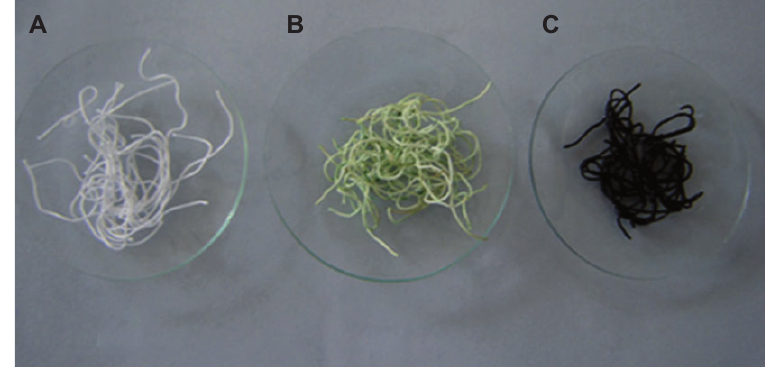
Figure 4 Picture showing plain cotton fibers (A), copper-bound chitosan-attached cellulose fibers (B), nanocopper loaded chitosan cotton fibers (C). Reprinted from J. Appl. Polym. Sci., 2009, vol. 11, Grace M, Bajpai SK, Chand N, Copper (II) ions and copper nano- particles-loaded chemically modified cotton cellulose fibers with fair antibacterial properties, pages 757–766, Copyright (2009), with permission from Wiley.